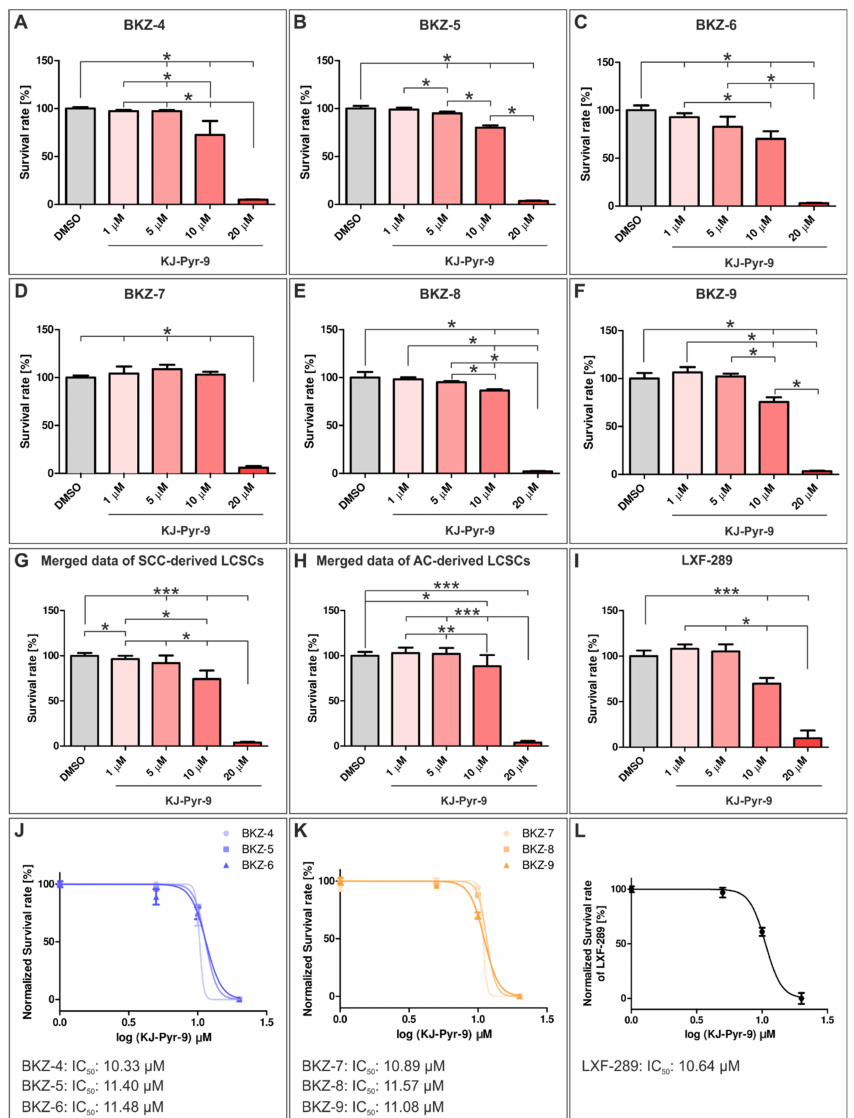
Figure 5. Inhibition of myc proto-oncogene (MYC) and N-myc proto-oncogene (NMYC) protein interac- tion with Myc-associated factor X significantly decreased survival of squamous cell carcinoma (SCC)- and adenocarcinoma (AC)-derived lung cancer stem cell (LCSC)-like cells. Metabolism was measured using Orangu, and cell count was determined by using a standard curve. Quantification of the normalized survival rate of SCC-derived ( A ) BKZ-4, ( B ) BKZ-5, and ( C ) BKZ-6 showed a significantly decreased survival after exposure to values greater than 5 µ M of the MYC/NMYC inhibitor KJ-Pyr-9 in comparison to the control. Calculation of the normalized survival rate for AC-derived ( D ) BKZ-7, ( E ) BKZ-8, and ( F ) BKZ-9 showed a significantly decreased survival after exposure to 20 µ M of KJ-Pyr-9 in comparison to the control. However, BKZ-8 and BKZ-9 seemed to be more sensitive in comparison to BKZ-7 as they also revealed a significantly decreased survival after the treatment with 10 µ M KJ-Pyr-9. ( G ) Merged data of SCC-derived LCSC-like cells showed a significantly reduced survival after treatment with KJ-Pyr-9, with values higher than 5 µ M for and ( J ) half maximal inhibitory concentration (IC 50 ) values between 10.33 and 11.48 µ M. ( H ) Quantification of merged data of AC-derived LCSC-like cell populations showed significantly reduced survival upon KJ-Pyr-9 values higher than 10 µ M. ( K ) IC 50 values ranged between 10.89 µ M and 11.57 µ M KJ-Pyr-9 for AC-derived LCSC-like cells. ( I ) Quantification of the survival of lung adenocarcinoma cell line LXF-289 showed significantly reduced survival after exposure to 10 µ M KJ-Pyr-9 with an ( L ) IC 50 of 10.64 µ M. Non-parametric Mann–Whitney test ( A – G , I , p ≤ 0.05). Unpaired t -test ( H , p ≤ 0.05). n = 3, * p ≤ 0.05, ** p ≤ 0.01, *** p ≤ 0.001. Mean ± SEM (standard error of the